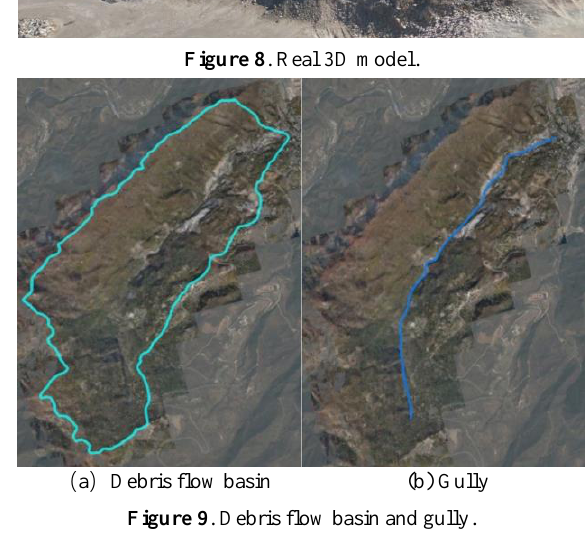
Figure 8 . Real 3D model.